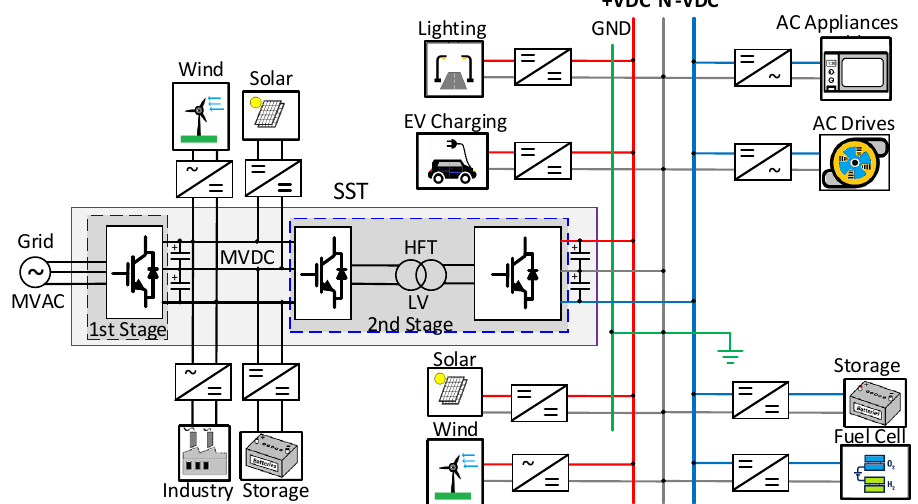
Figure 10. A vision for a DC infrastructure in which an interconnection of a Medium-Voltage DC grid with a Low-Voltage DC grid is used.